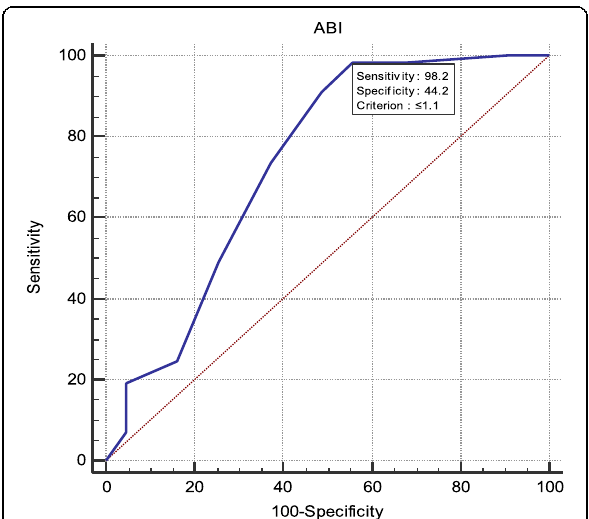
Fig. 2 High sensitivity of ABPM SBP with ABI (98.2%)